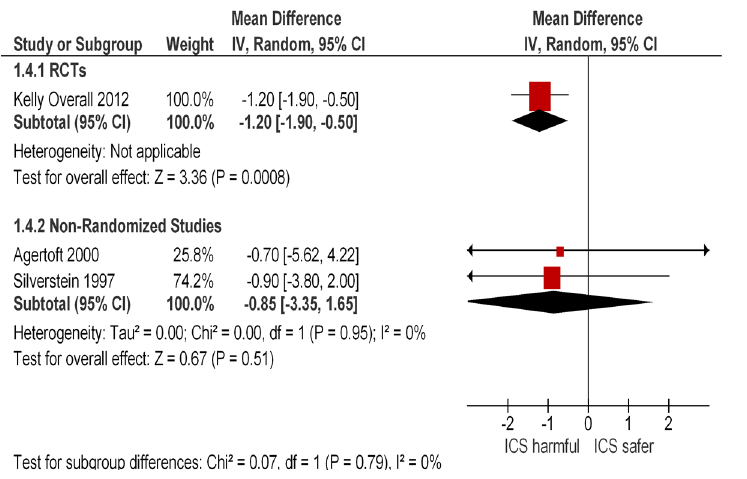
Fig 2. Final Adult Height, ICS users vs. non-users.